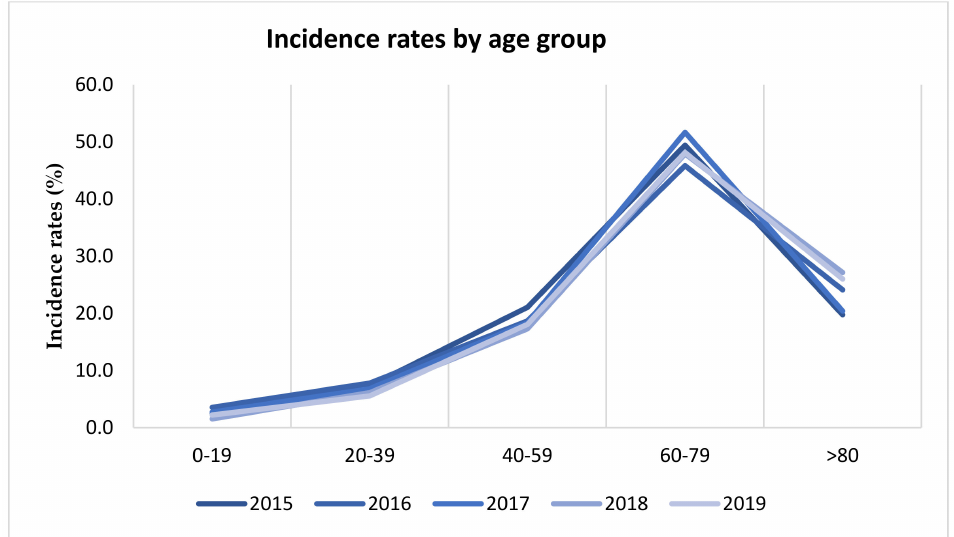
Figure 1. Distribution of positive cases by age group.